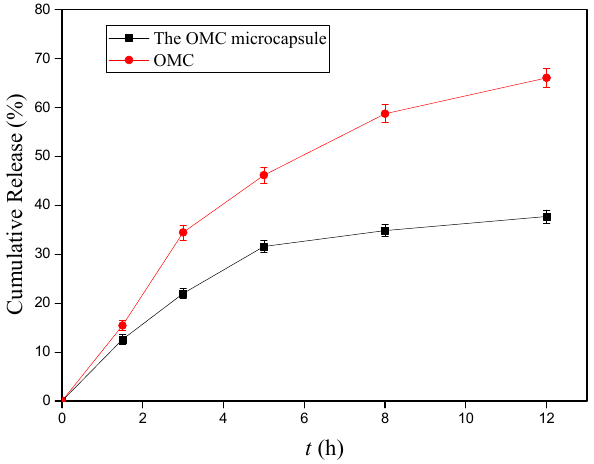
Figure 10. Cumulative release of OMC and the OMC microcapsule.